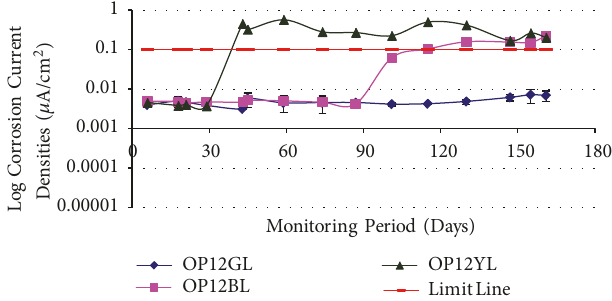
Figure 12: Log corrosion current densities versus time for OPC at w/c